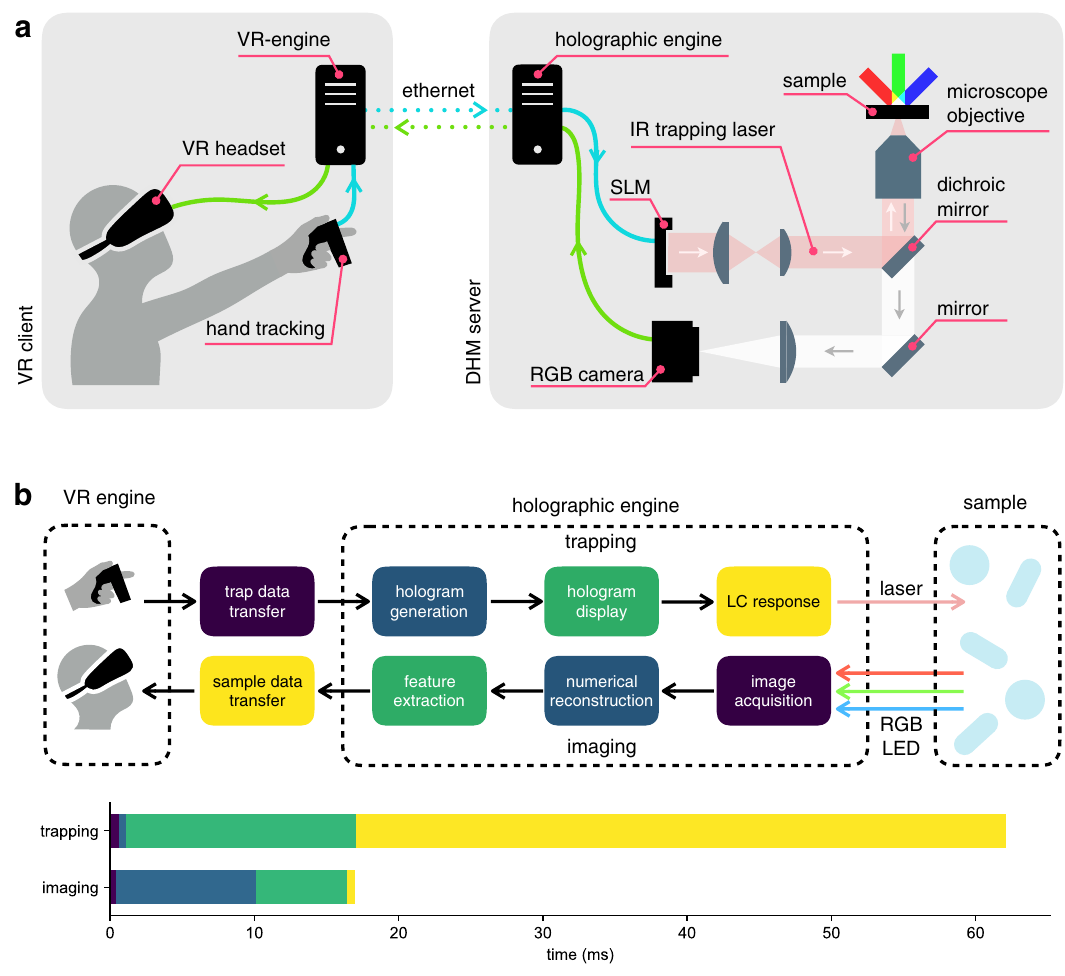
Figure 1. ( a ) Schematic view of the optical and computer hardware setup. The sample is illuminated by three tilted RGB LEDs and a 100 × magnified image is captured by a color camera. The “holographic engine”, running on a control PC in the lab, performs 3D numerical reconstructions and identifies the objects in the field of view. Position and shape parameters of the objects are sent to a remote PC running a “VR-engine” that renders the objects on a VR headset. Hand tracking input data is transferred back to the “holographic engine” for the computer generation of digital holograms to be displayed on the SLM. The SLM shapes the wavefront of an IR laser beam that is then focused by the same imaging objective to generate the desired 3D traps arrangement. ( b ) Data and optical flow diagram and related timing chart. Chart colors correspond to the boxes above it. This figure was made with Keynote 26